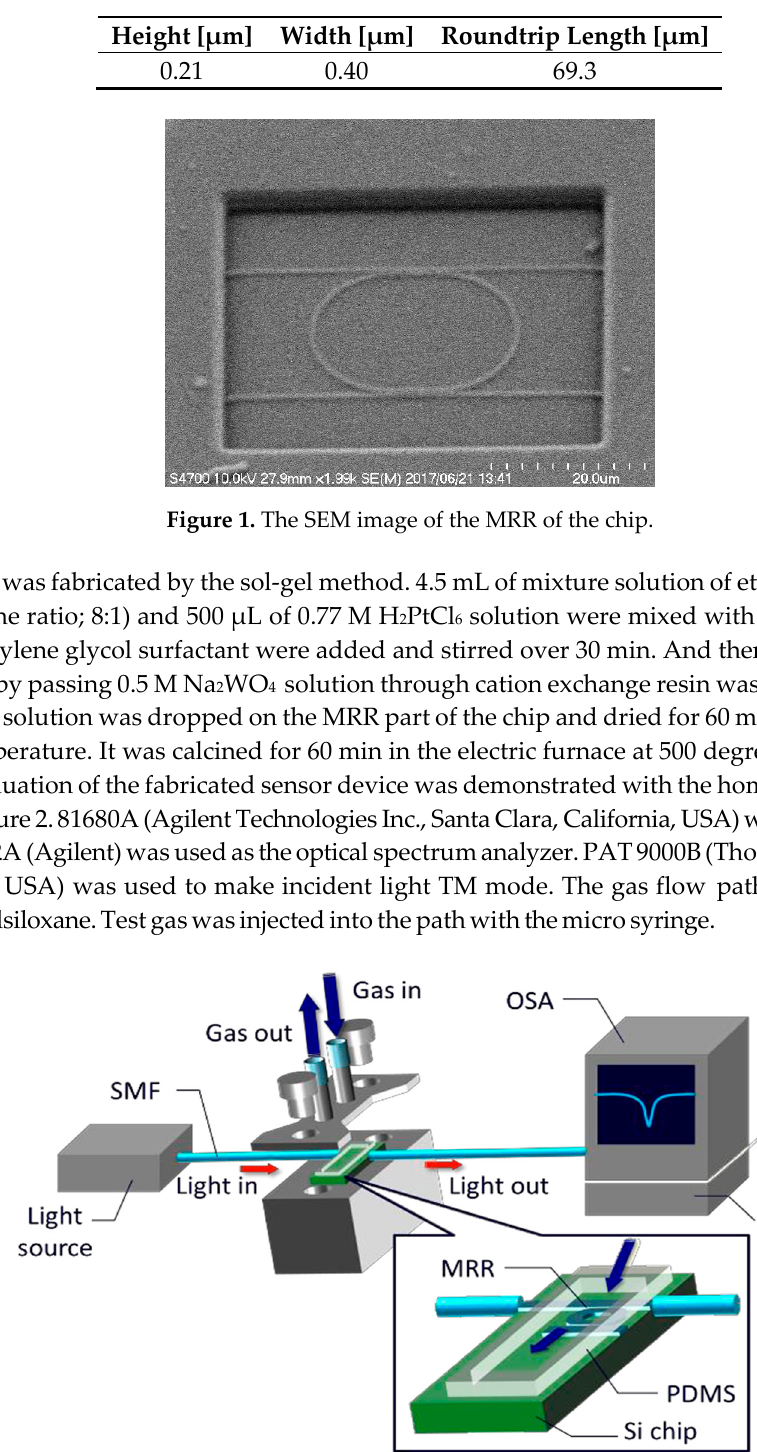
Table 1. The size of the MRR.